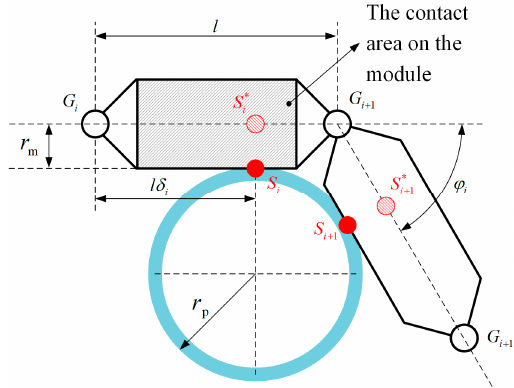
Figure 6. The contact geometry between the adjacent joint module and cylinder.